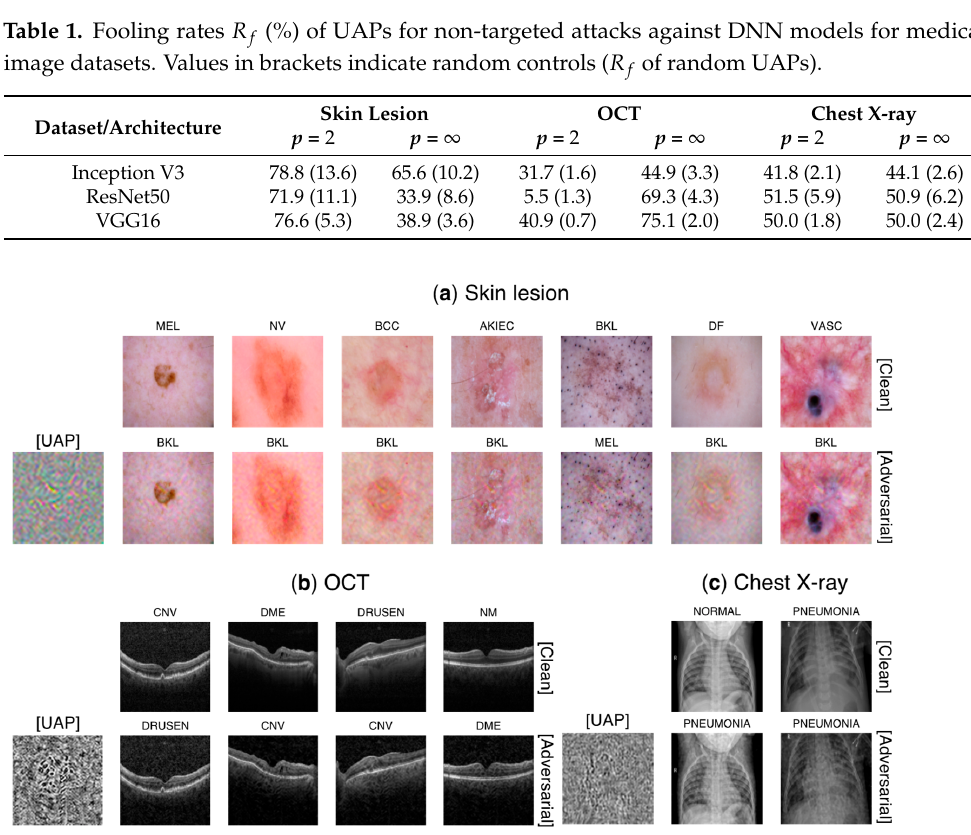
Figure 1. Clean images and their adversarial images generated using nontargeted UAPs against